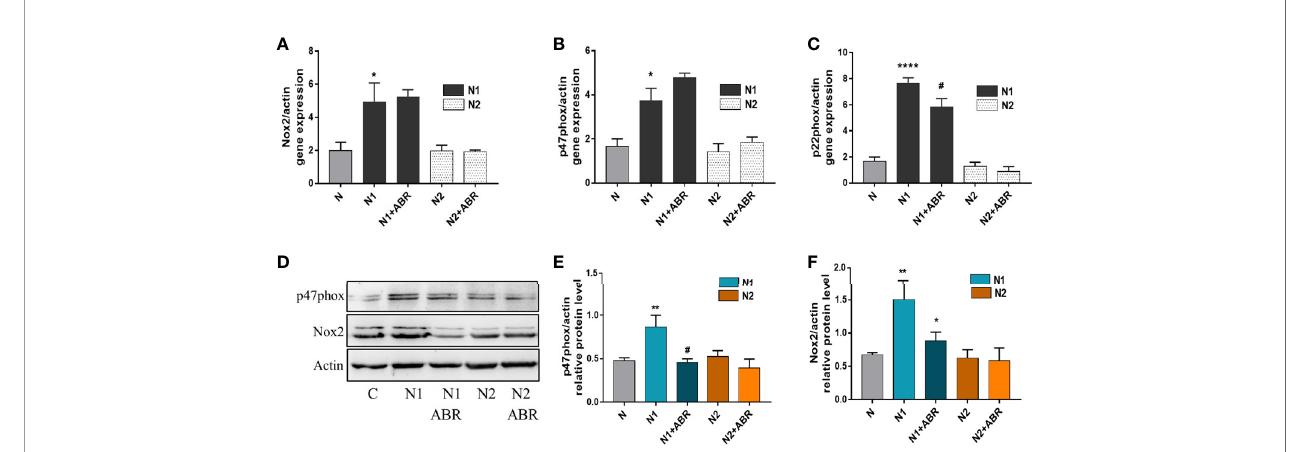
FIGURE 6 | Gene and protein expression of NADPH oxidase subunits in the different neutrophil populations in the presence or absence of ABR-238901 (ABR). (A-C) Quanti fi cation of gene expression for NADPH oxidase subunits Nox2, p47phox and p22phox by qPCR. (D-F) Protein expression of NADPH oxidase subunits p47phox and Nox2 determined by Western blot. n = 3, *p < 0.05, **p < 0.01 ****p < 0.0001 (N1 versus control); # p<0.05 (N1 versus N1 + ABR).